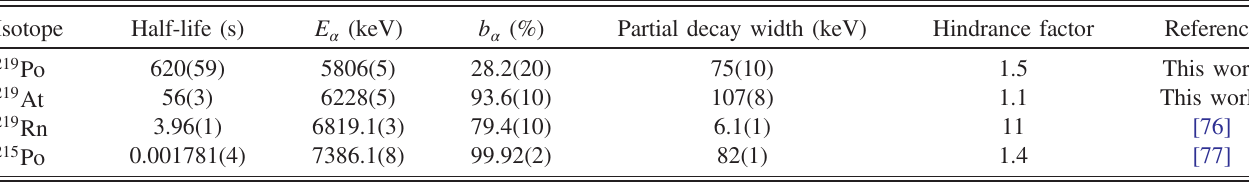
TABLE III. Decay properties of 219 Po and its progenies 219 At, 219 Rn, and 215 Po.